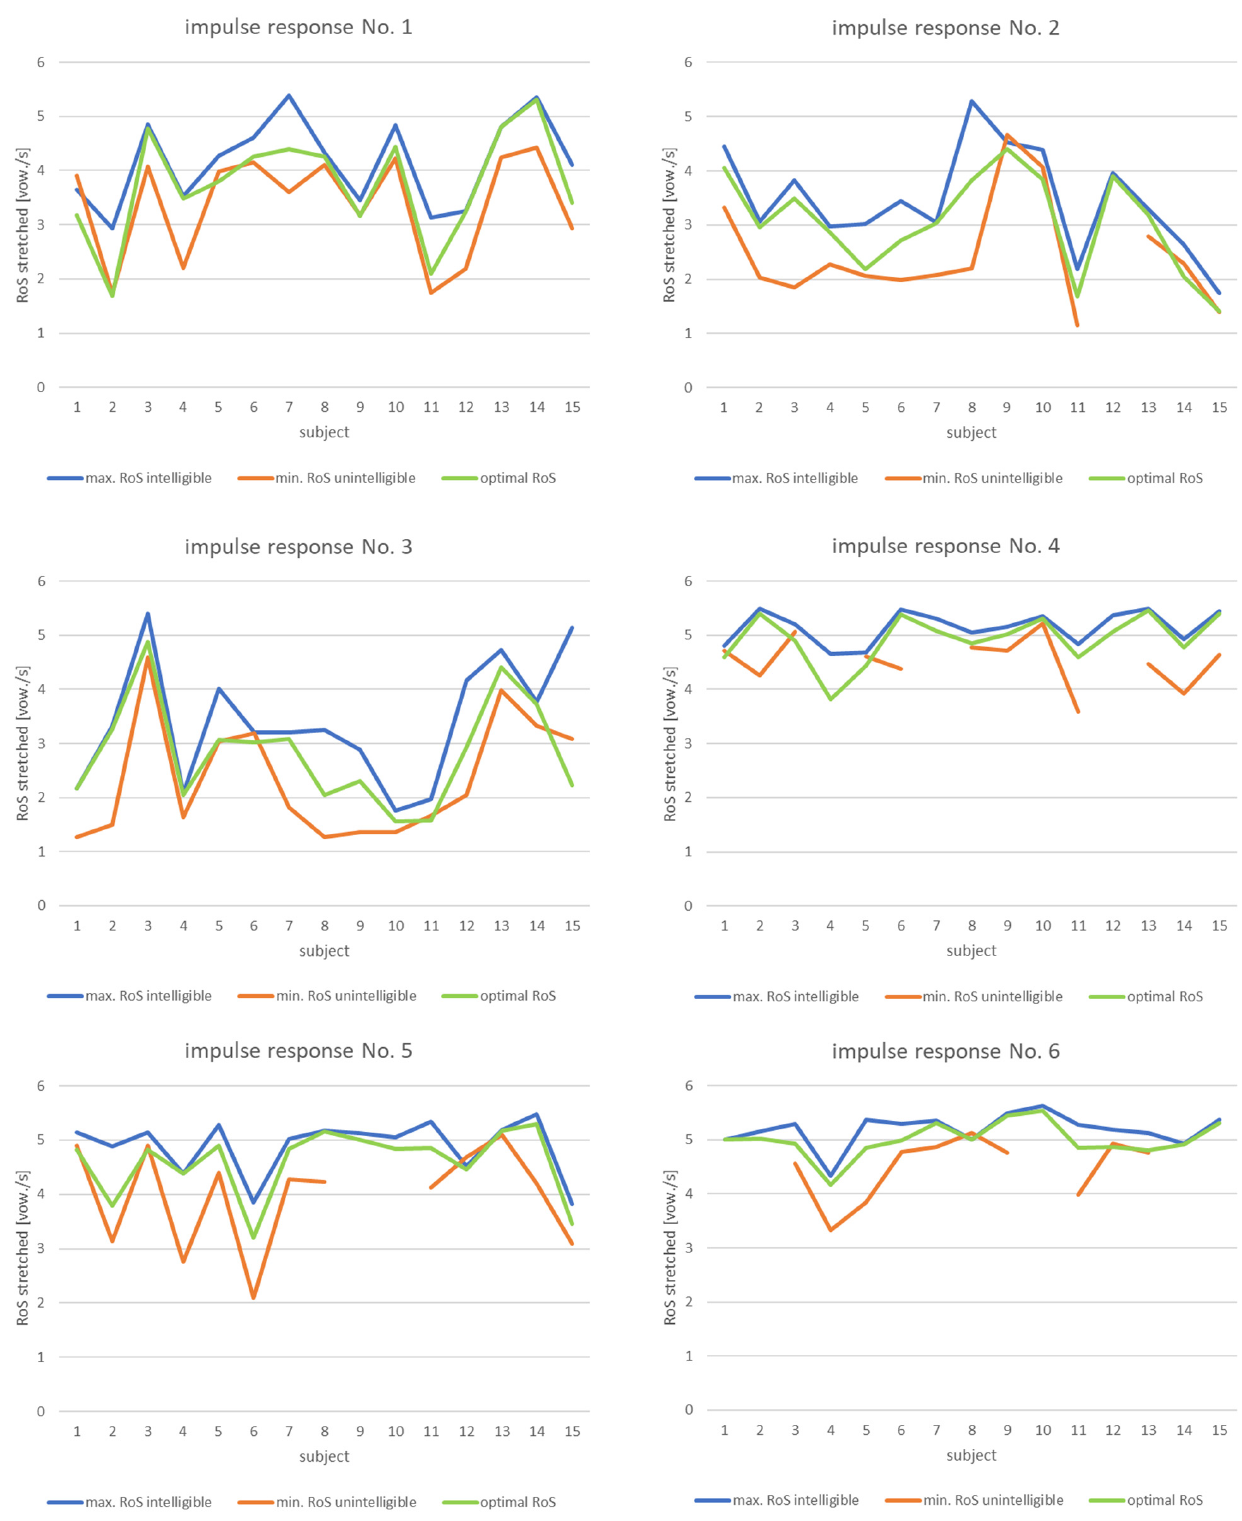
Figure 3. Results for obtained for particular impulse